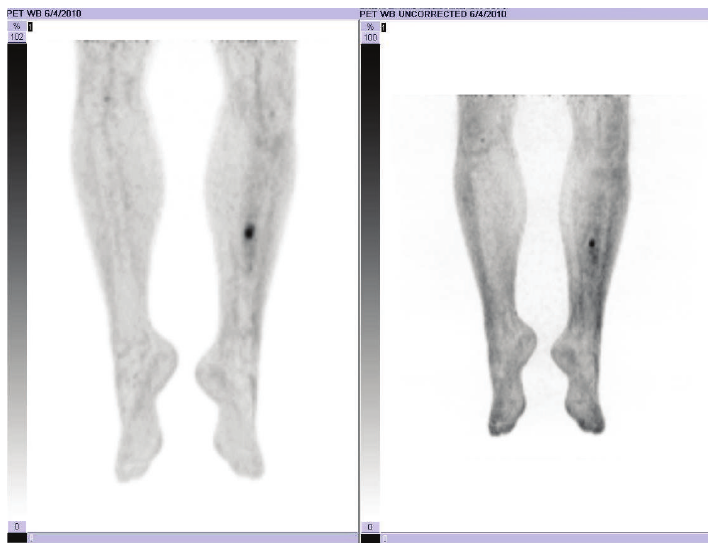
Figure 5: Postrebiopsy planar PET/CT image demonstrating no evidence of contiguous spread nor systemic recurrence.